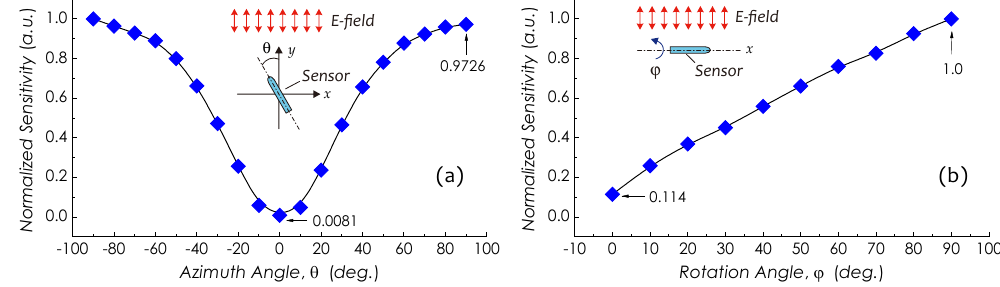
Figure 13. Directionalities of sensor about ( a ) vertical and ( b ) longitudinal